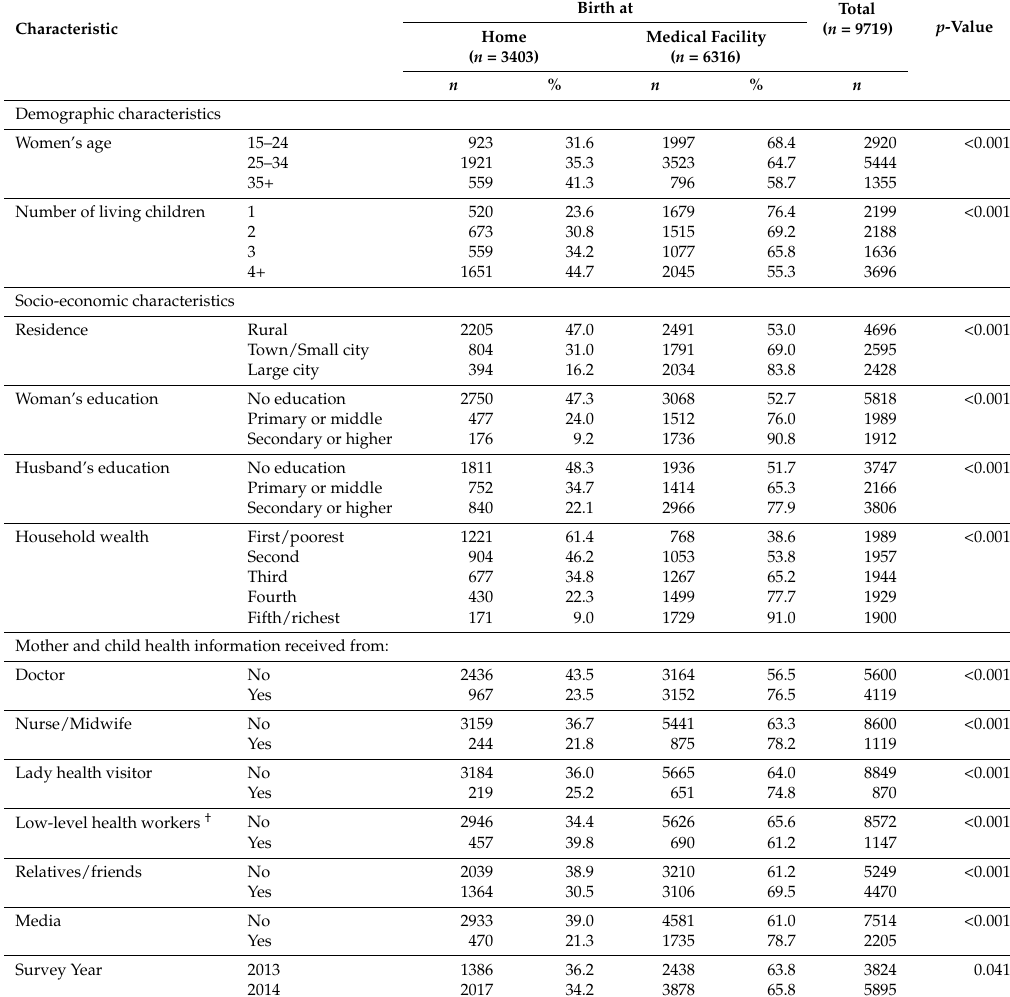
Table 1. Characteristics of respondents, by place of